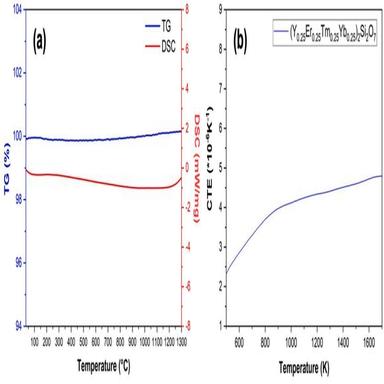
(a) TG and DSC plot of bulk (Y0,25Er0,25Tm0,25Yb0,25)2Si2O7 from room temperature to 1300 ℃ and (b) Coefficient of thermal expansion (CTE) curve of (Y0,25Er0,25Tm0,25Yb0,25)2Si2O7 from 500 K to 1700 K.